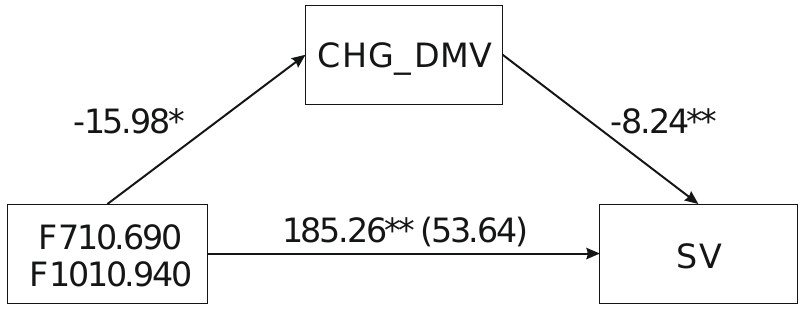
Figure 2. Mediation analysis of compounds associated with infrared spectral regions of 710–690 and 1010–940 cm −1 to demonstrate their effect on sequence variation (SV) via the demethylation of the CHG sequence context (CHG_DMV). * p < 0.05, ** p < 0.01 Table 2. Outcomes of mediation analyses from F710.690, F1010.940, and F710.690-F1010.940 to sequence variation assessing indirect effects. The unstandardized coefficients are given and explained in the table.